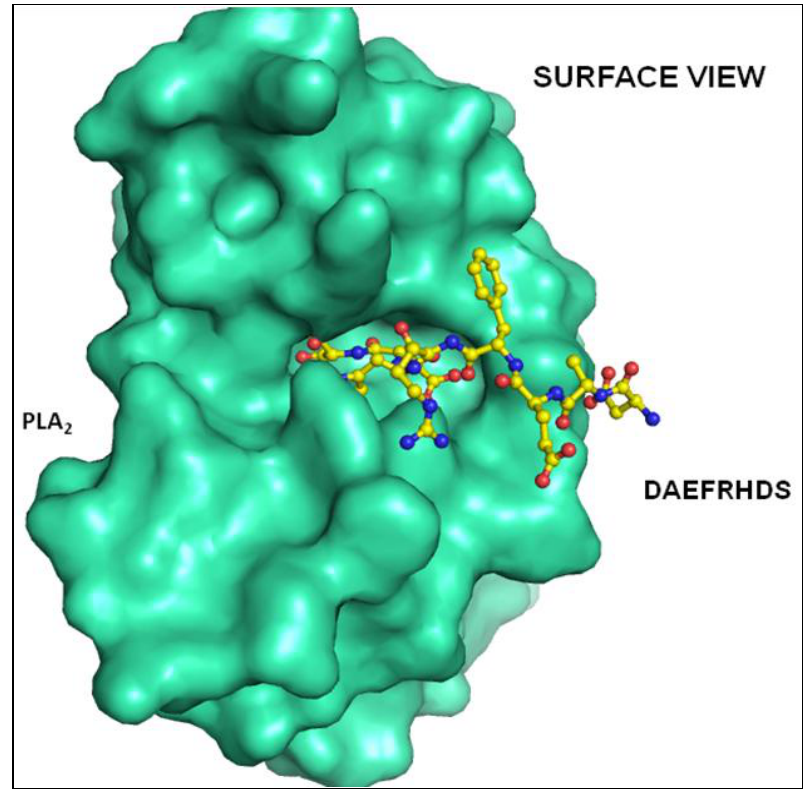
Figure 7. Surface diagram representation of the binding cavity and the hydrophobic channel with the peptide DAEFRHDS going inside the pocket.